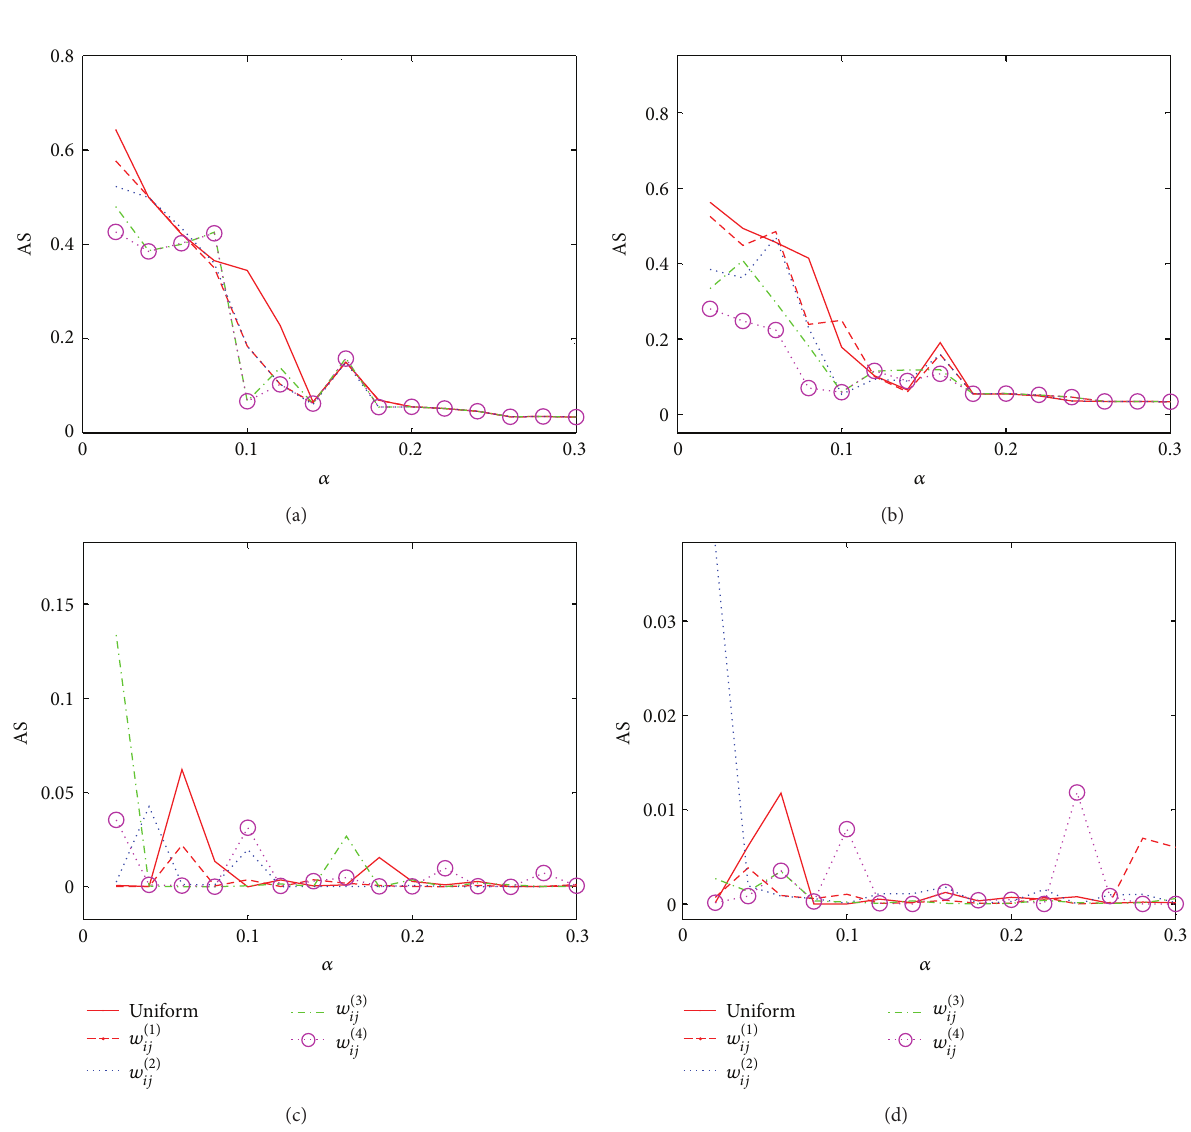
Figure 3: For autonomous system network, after the cascade stops, the avalanche size AS as a function of 𝛼 for different strategies with (a) 𝜏 = 20 under HL attack, (b) 𝜏 = 100 under HL attack, (c) 𝜏 = 20 under RA attack, and (d) 𝜏 = 100 under RA attack, respectively. Here (c) and (d) are averaged over 20